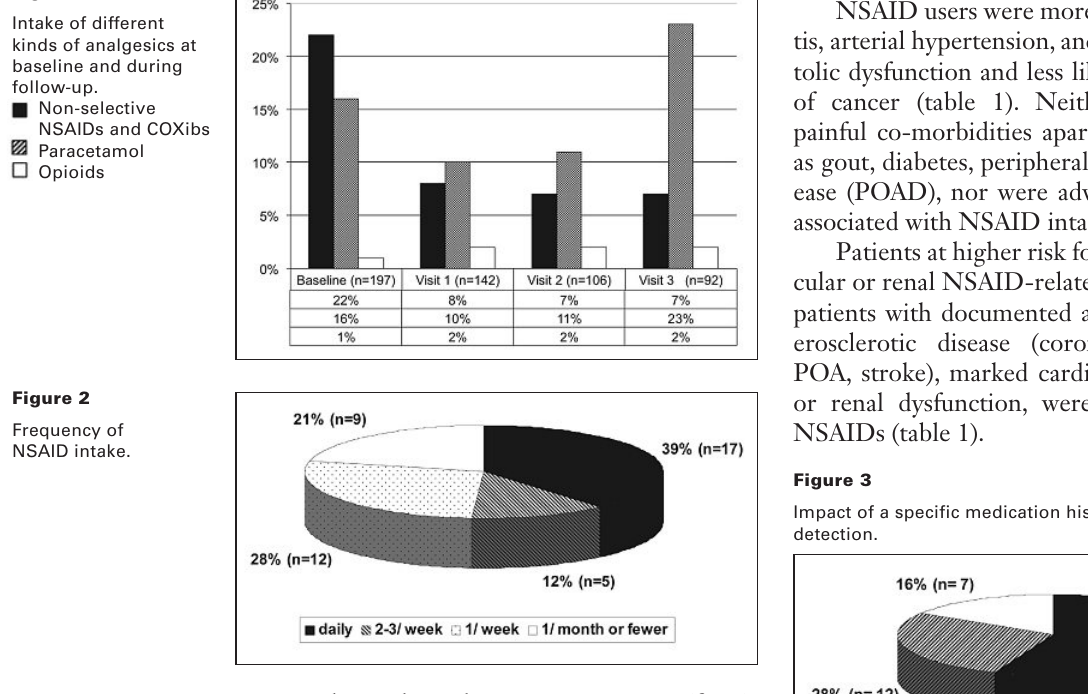
Intake of different kinds of analgesics at baseline and during follow-up.